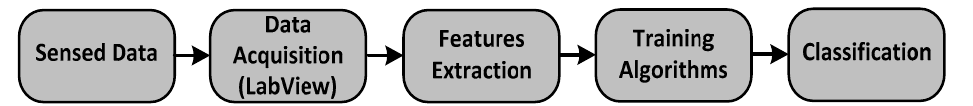
Figure 11. Overall data acquisition, feature extraction and data classification analysis flow for the gait analysis system using our WGAS.